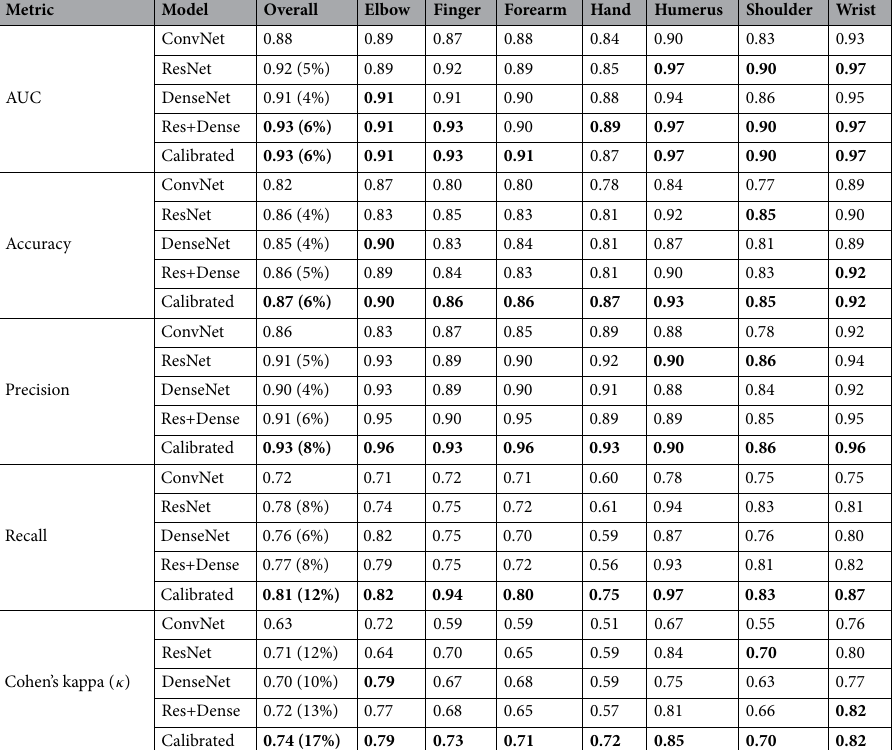
Table 3. Performance comparison of five models—overall and across different parts of body. Bold numbers indicate the highest performing model(s) for each evaluation metric across eight studies. The numbers in parenthesis indicate the percentage change ( P M − P ConvNet )/ P ConvNet in a particular evaluation metric for a model M over the baseline ConvNet model. “Res+Dense” is a meta-learner which makes its predictions based on the average of the output probabilities from the ResNet and DenseNet models. “Calibrated” is our proposed ensemble model which trains a designated deep learner for each anatomical